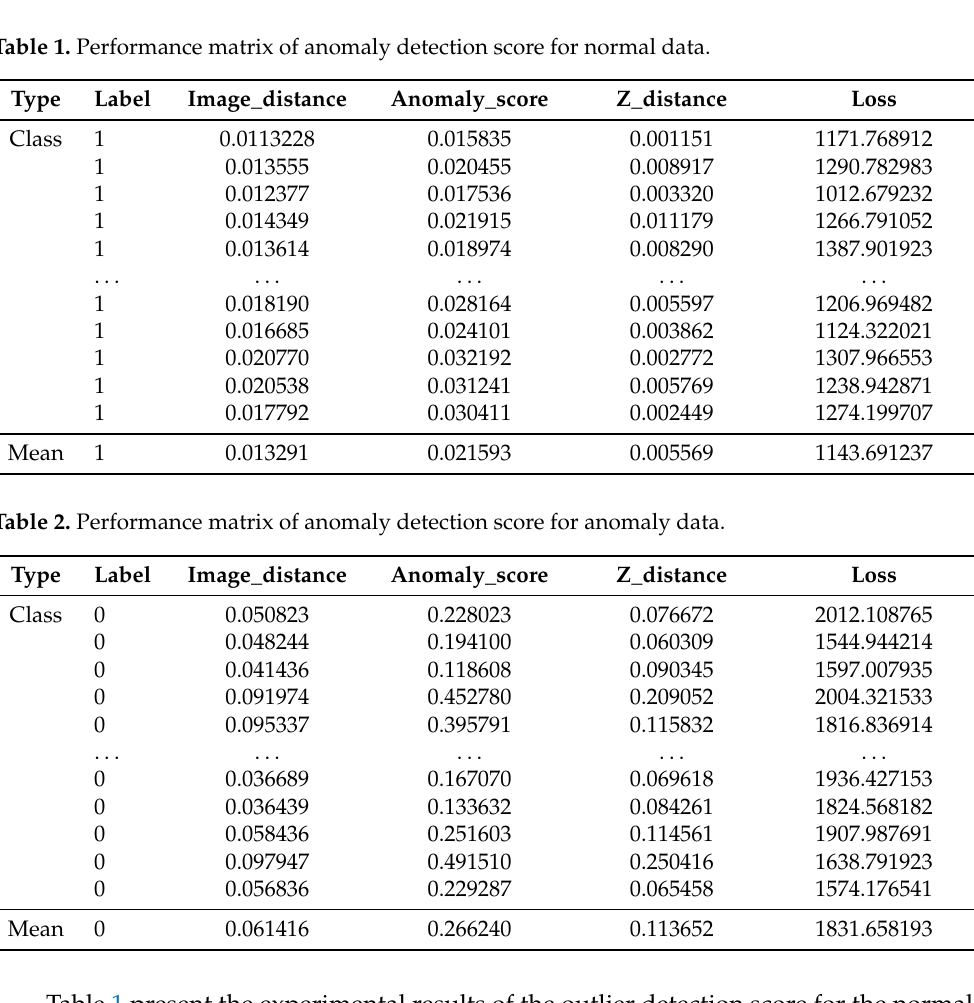
Table 1 present the experimental results of the outlier detection score for the